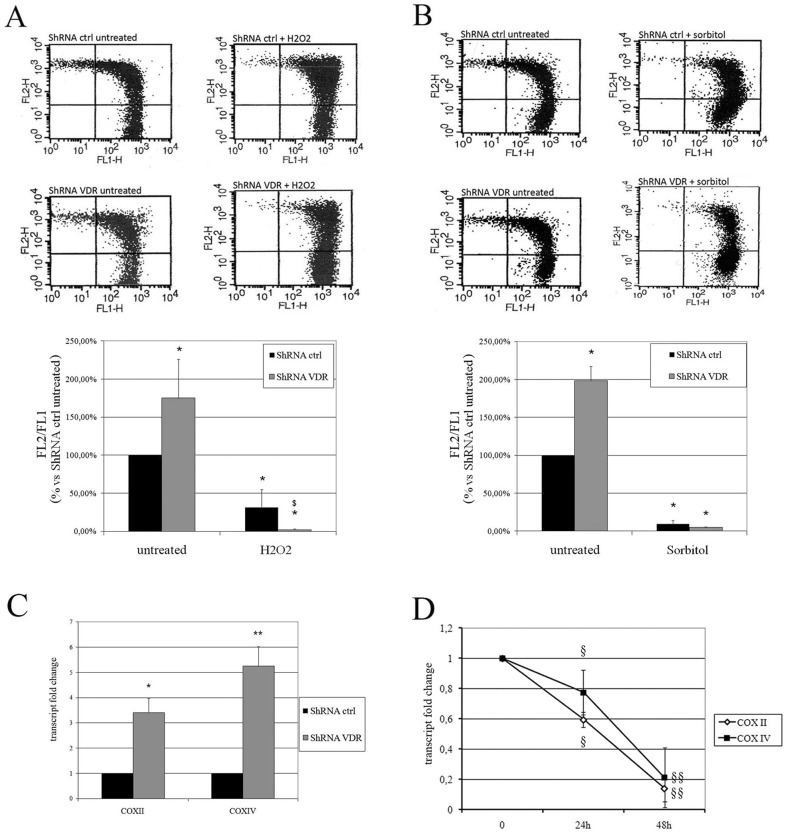
Effects of VDR silencing on mitochondrial activity.HaCaT cells were infected with shRNA control or VDR shRNA 3 and the mitochondrial membrane potential was examined using JC-1 cytofluorimetric evaluation, in the presence or absence of two different stressors: (A) Control and silenced cells were treated with either 10 mM H2O2 or (B) 0.5 M sorbitol. In both figures, a representative image from the cytofluorimetric analysis is shown in the top panel, whereas the results from three separate experiments are plotted in the graph in the lower panel. The FL-2/FL-1 ratio was calculated and the values are expressed as a percentage of the untreated shRNA control. * P<0.05 compared to the untreated shRNA control, $ P<0.05 compared to the treated shRNA control. (C) Real time analysis of COX II (COX II) and IV (COX IV) subunit transcript expression in control and silenced cells. Fold changes are plotted on the graphs as the means ±SD of three independent experiments. * P<0.05 and ** P<0.01 compared to the shRNA control. (D) HaCaT cells were grown in the presence or absence of 10 nM vitamin D and COX II and COX IV transcript expression were evaluated using real-time analysis after 24 and 48 hours of treatment. The values plotted on the graphs represent the fold change in transcript expression in treated versus untreated cells and are displayed as the means ±SD of three independent experiments. § P<0.05 and §§ P<0.01 compared to the untreated cells.